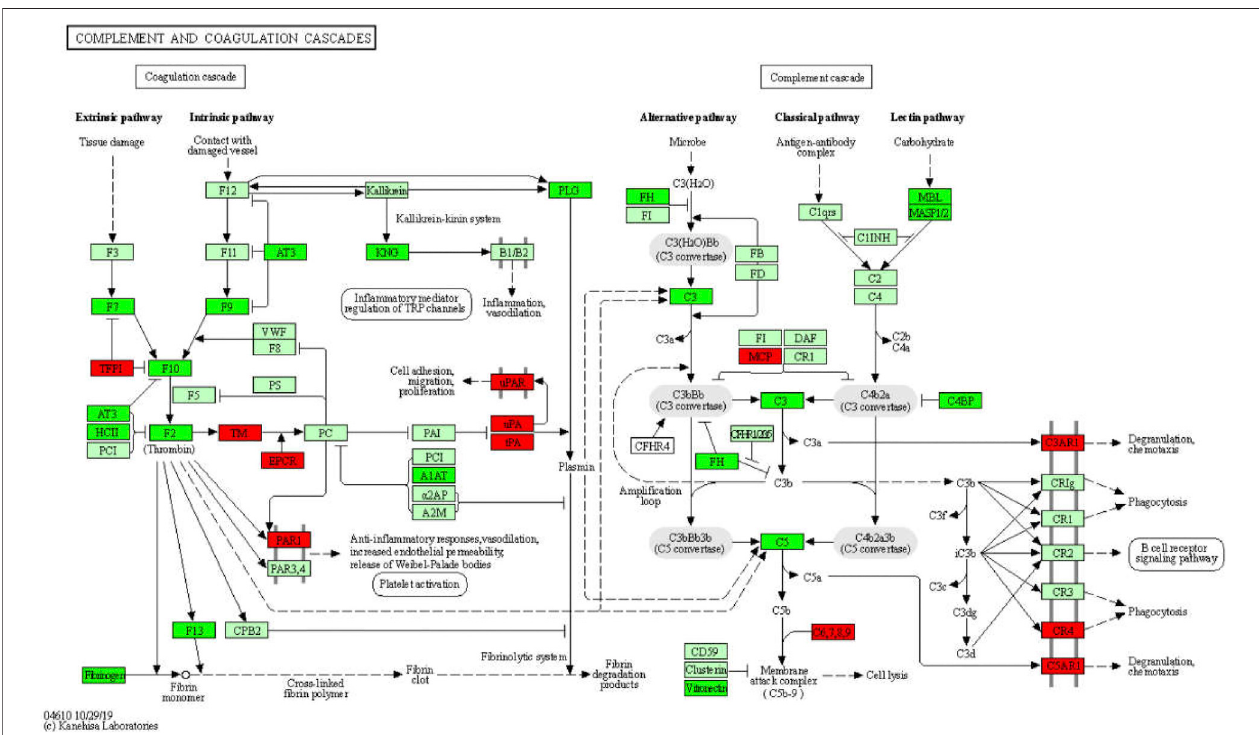
FIGURE 9 | Signi fi cantly enriched KEGG pathways in complement and coagulation